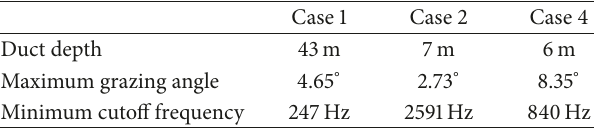
Table 2: Acoustic characters of duct